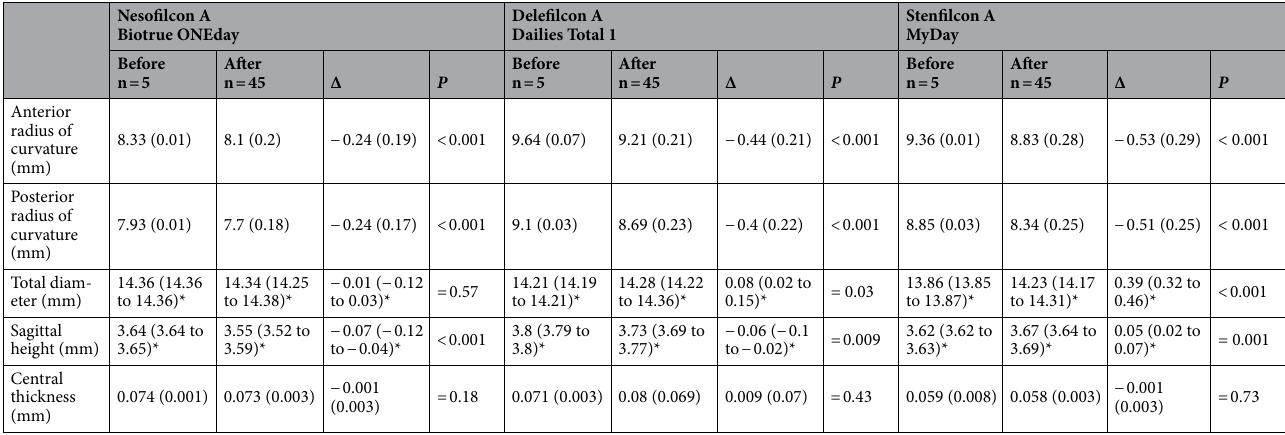
Table 4. Changes in total diameter, sagittal height, and central thickness for three material types of daily disposable SCLs; mean values (SD). *Median